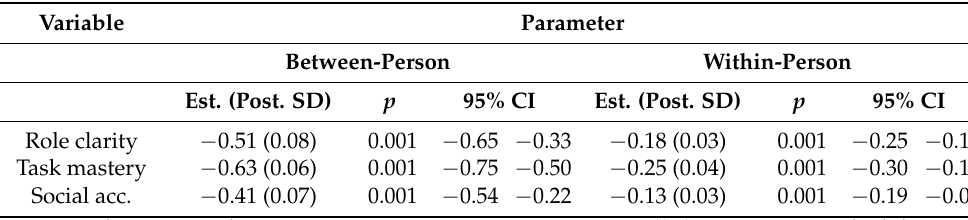
Table 4. Fixed effects of relations between between-person and within-person components of role clarity, task mastery, and social acceptance, and perceived stress ( n =